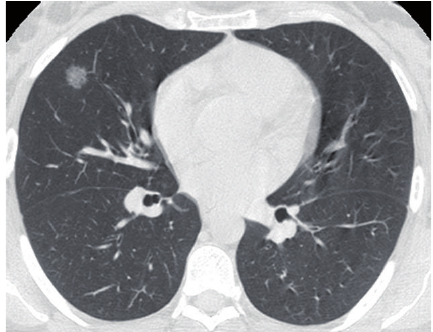
Figure 2: HRCT at the level of the middle lobe shows a 1.4cm ill- defined nodule of a ground-glass opacity in the right middle lobe demonstrating air